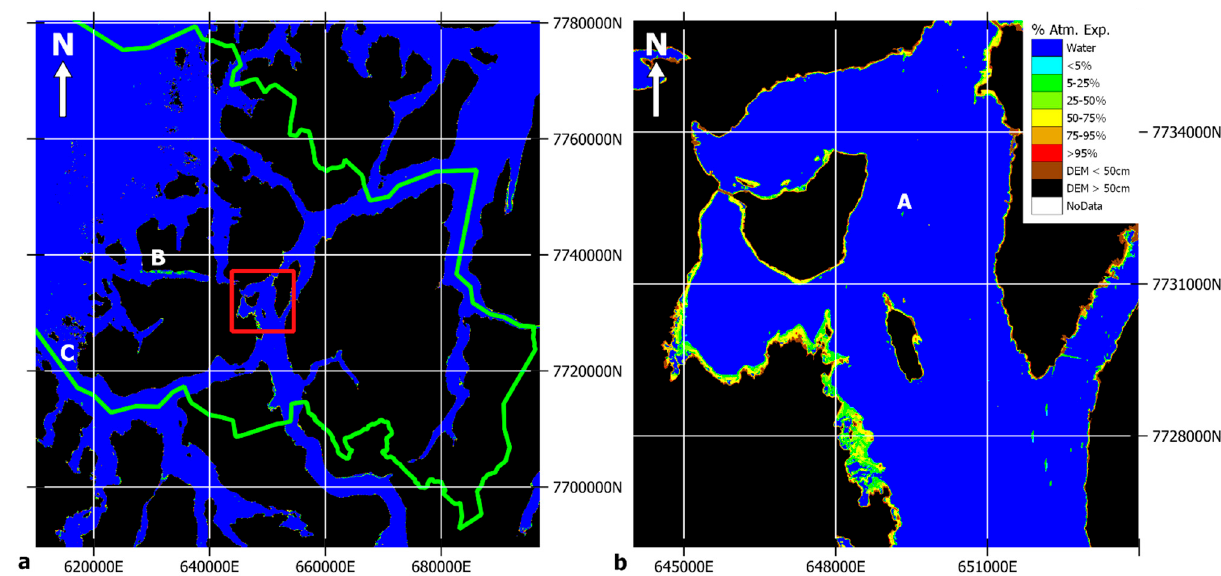
Figure 12. Percentage of atmospheric exposure results over ( a ) the whole Tromsø Municipality and ( b ) the areas of Langnes and Lille Grindøy (red rectangle in ( a )). Errors in misclassification from ship traffic signs or ship traffic (A), radar side lobes reflection of steep slopes in east–west-directed fjords (B), and fish farms (C) are indicated.